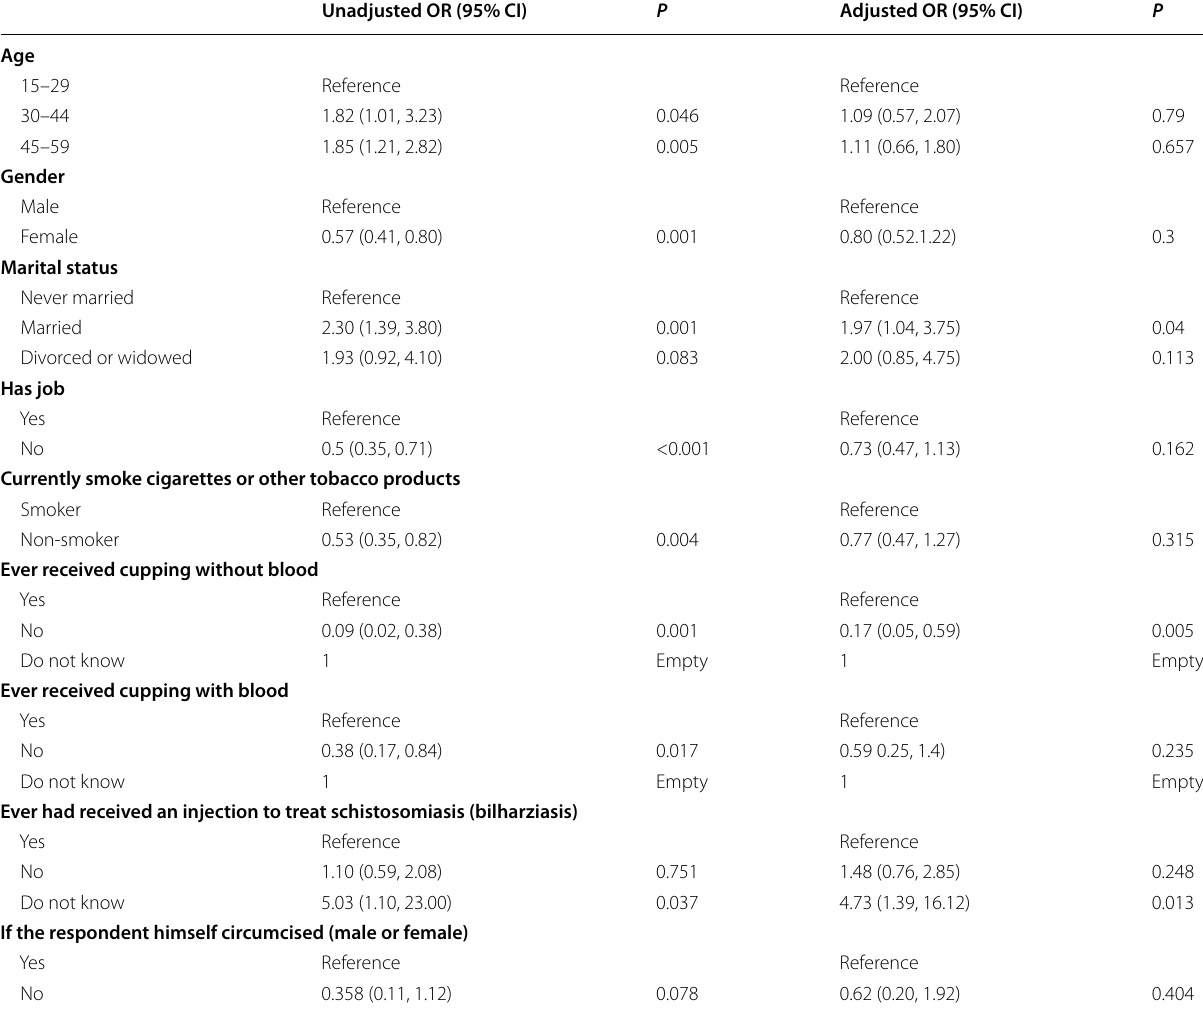
Abbreviations : Wt.% weighted percent, OR odds ratio, Cl confidence